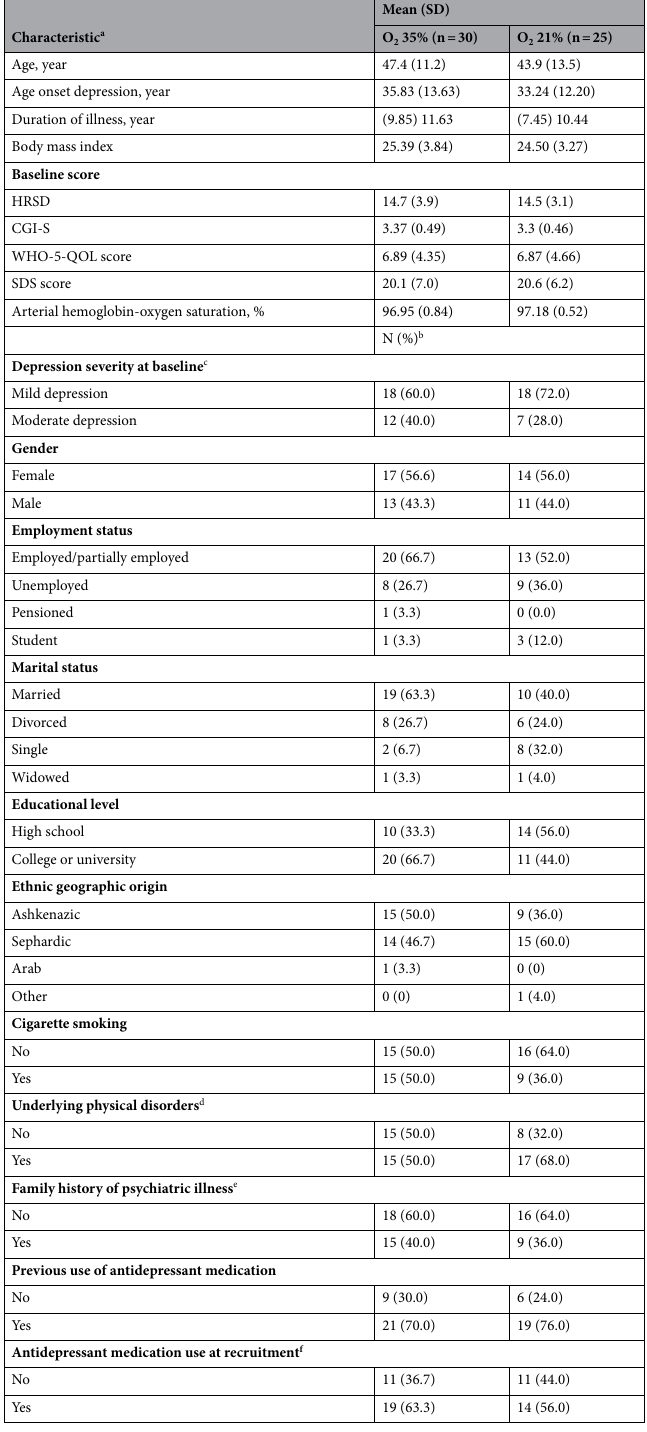
Table 1. Demographic and clinical characteristics of recruited participants at baseline. CGI-S Clinical Global Impression-severity, HRSD Hamilton rating scale for depression, SD standard deviation, SDS Sheehan disability scale, SOC sense of coherence, WHO-5-QOL world health organization-5 quality of life (questionnaire). a Using T -test or chi-square test (according to type of parameter), there were no significant differences between the groups in any of the tested parameters. b Percent in 35% O 2 -treated or 21% O 2 -treated groups. c Depression severity based on Clinical Global Impression: mild—2–3, moderate—4. d Including the following diseases: Attention deficit hyperactive disorder, fibromyalgia, hypothyroidism, cancer, anemia, eye disorder, heart disease, psoriasis, stomach/peptic disease, migraine, irritable bowel disease, other. e Including the following illnesses: Anxiety disorders, bipolar disorder, depressive disorder, mental retardation, obsessive–compulsive disorder, posttraumatic stress disorder, schizophrenia, other. f There was no difference between the groups in the incidence of a particular drug or a medication family (such tricyclic antidepressants or selective serotonin reuptake